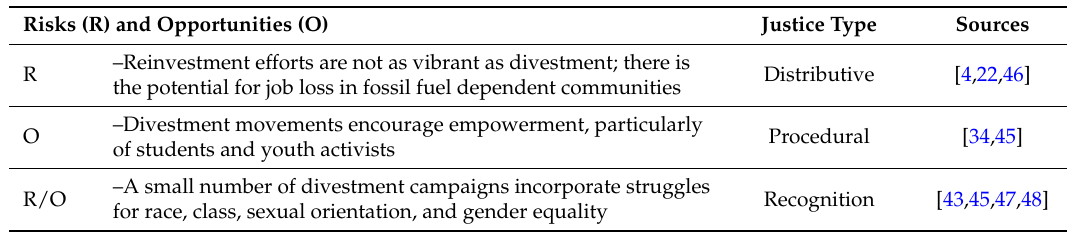
Table 2. Equity and justice potential from